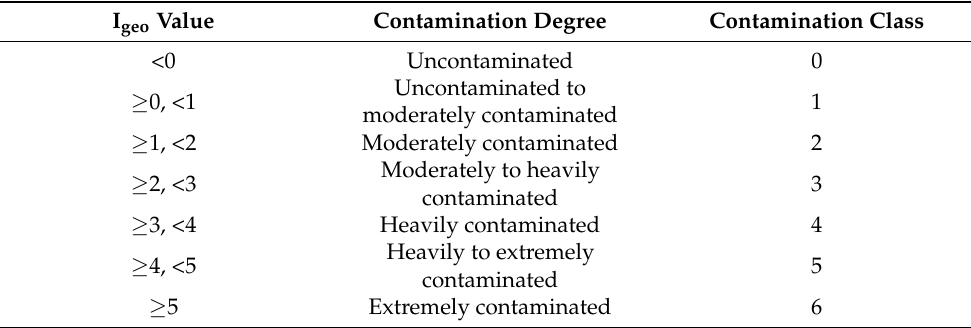
Table 2. Classification of contamination degree based on I geo